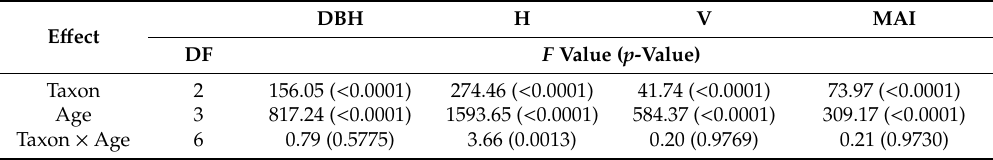
Table 3. Results of the generalized linear mixed model (GLIMMIX) analysis of growth traits of taxa: type III tests of fixed effects.